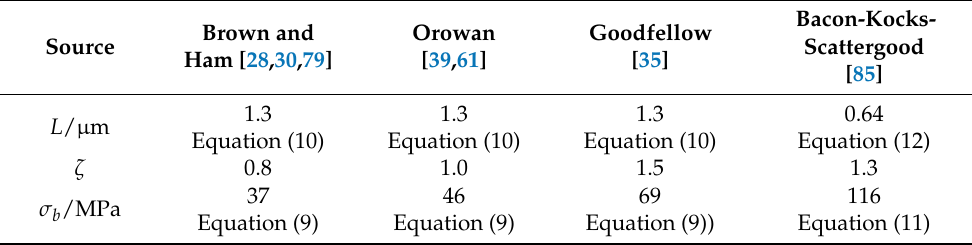
Table 5. Calculated Orowan bowing strengthening contributions using the various relationships found in the